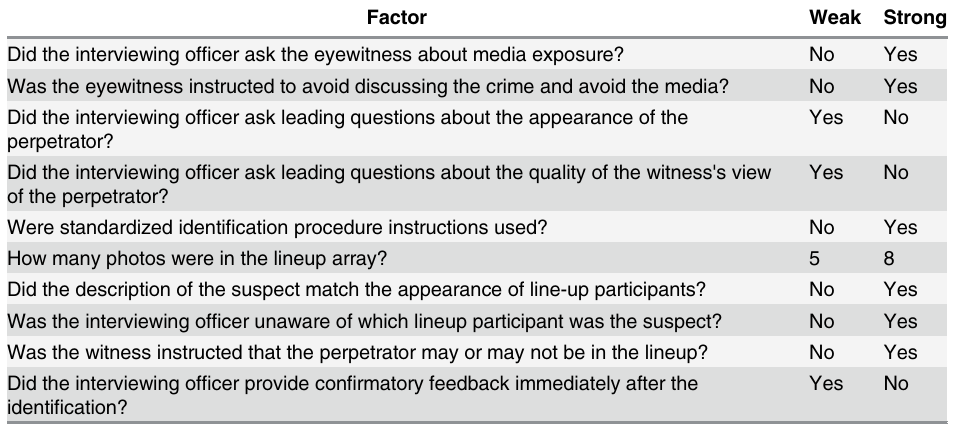
Table 1. Operationalization of ID Quality. Factor Weak